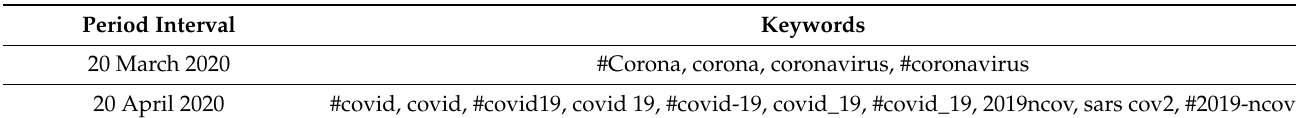
Table 2. Sample filtering keywords for COVID-19.